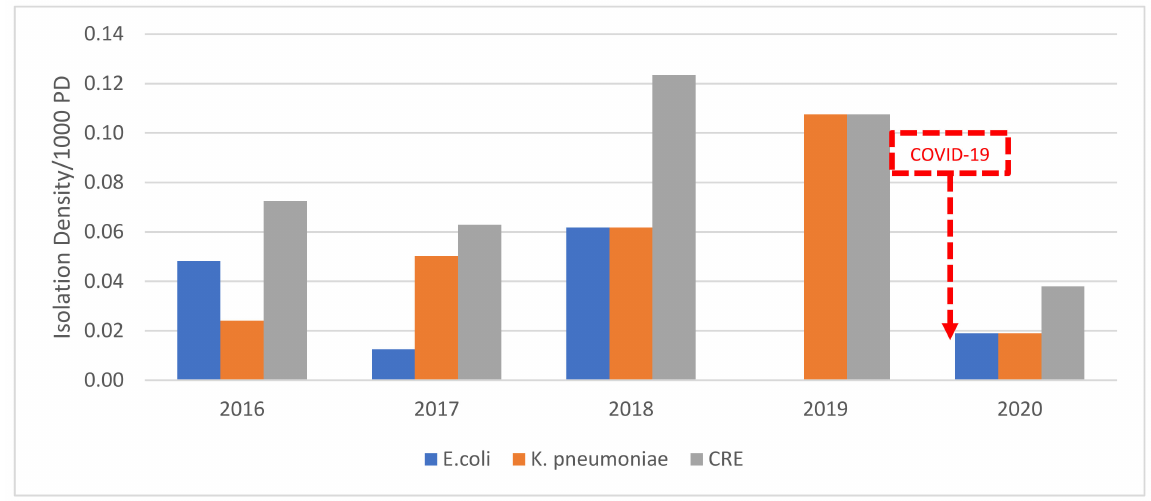
Figure 3. The isolation density per 1000 PD of carbapenem-resistant E. coli and K. pneumoniae bloodstream isolates from 2015–2020 at